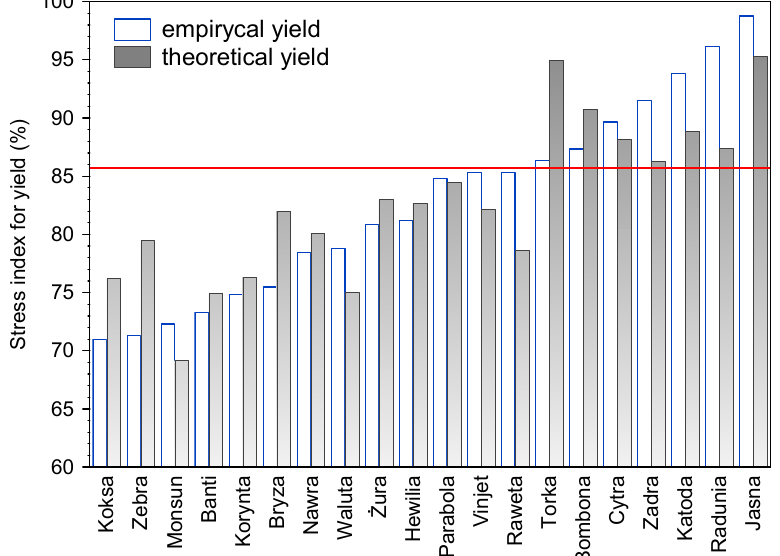
Figure 1. The values of drought stress index for the final empirical grain yield and yield calculated based on multiple regression equation—theoretical yield (Table 4) for the 20 varieties of spring wheat. Horizontal line defines seven most tolerant varieties to drought in empirical and theoretical